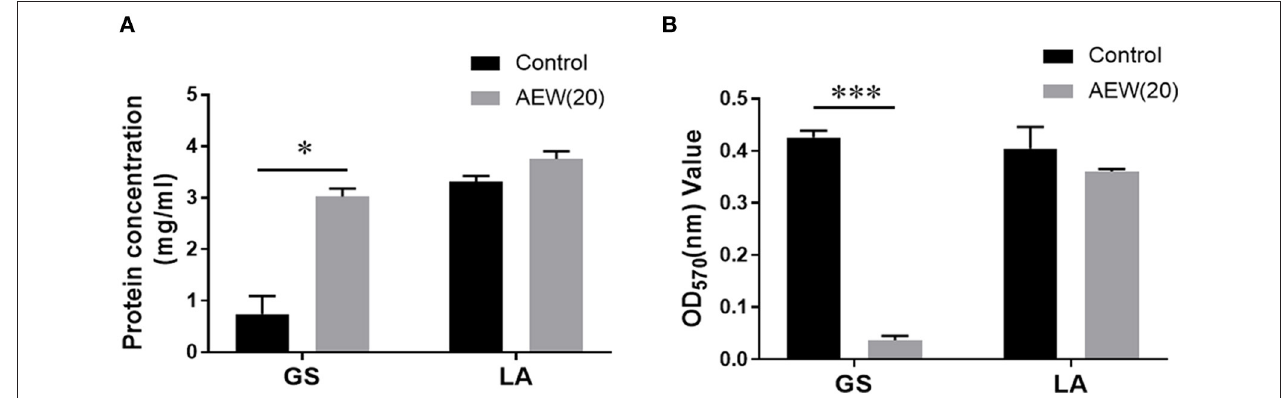
FIGURE 3 | Twenty ppm AEW promoted protein leakage and cell lysis of GS with less effect on LA. (A) Statistics showed the GS and LA proteins in the supernatant after 20 ppm AEW treatment using the BCA method (n = 3, * p < 0.05 vs. control). (B) The data showed the absorbance of GS and LA precipitates after 20 ppm AEW treatment ( n = 3, *** p < 0.001 vs.